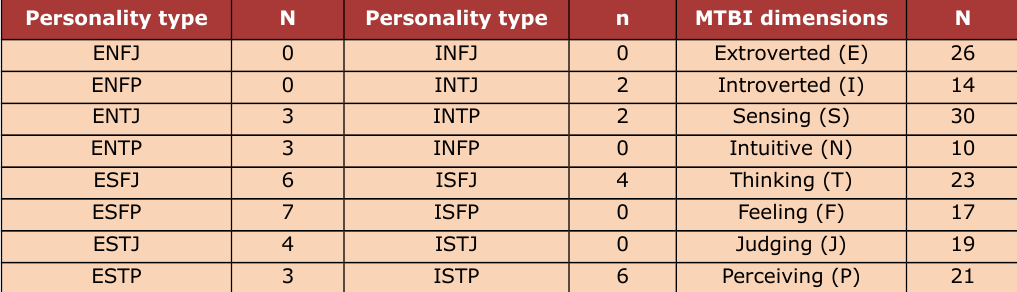
Table 3. Personality types of project